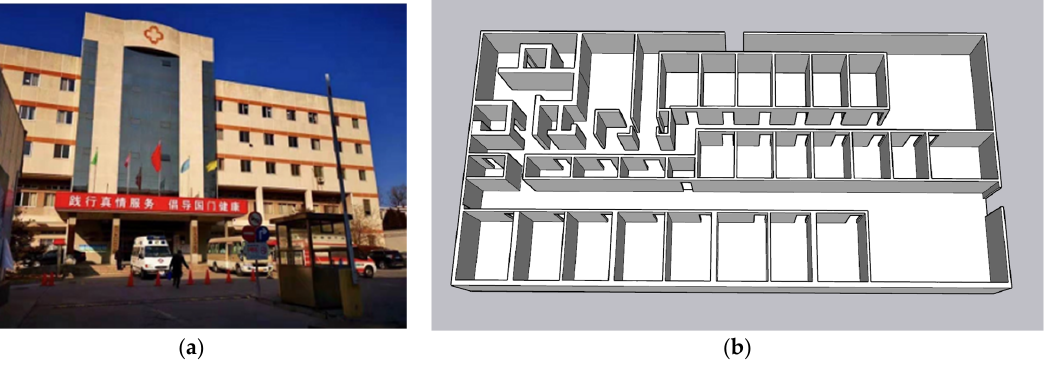
Figure 2. West Building of Beijing Capital Airport Emergency Center: ( a ) exterior view of the emergency center; and ( b ) first floor plan of the emergency center building.